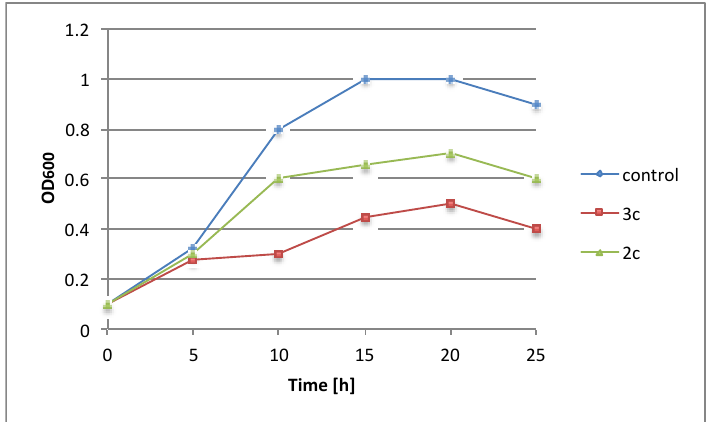
Figure 2. Optical density (OD600) of S. epidermidis ATCC 12228 cells incubated with compound 2c (green line), compound 3c (red line) and control, untreated cells (blue line).